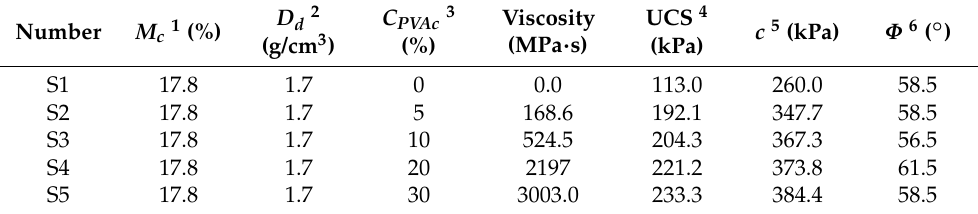
Table 5. The results of the strength tests .